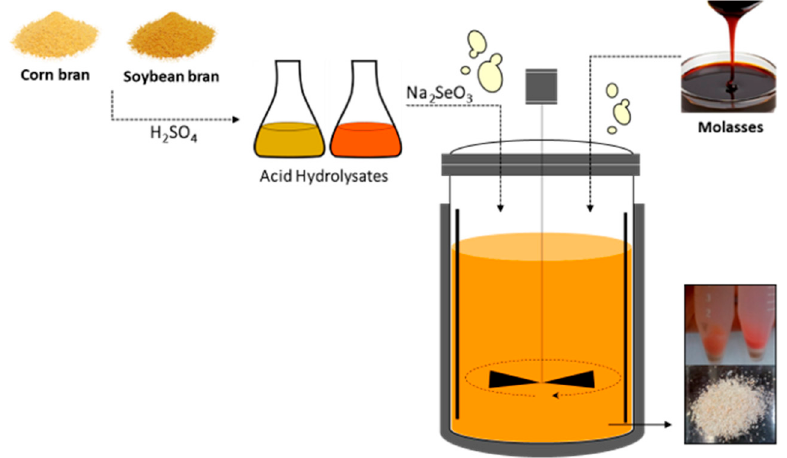
Figure 2. Scheme of preparation media of the cultivation yeast.